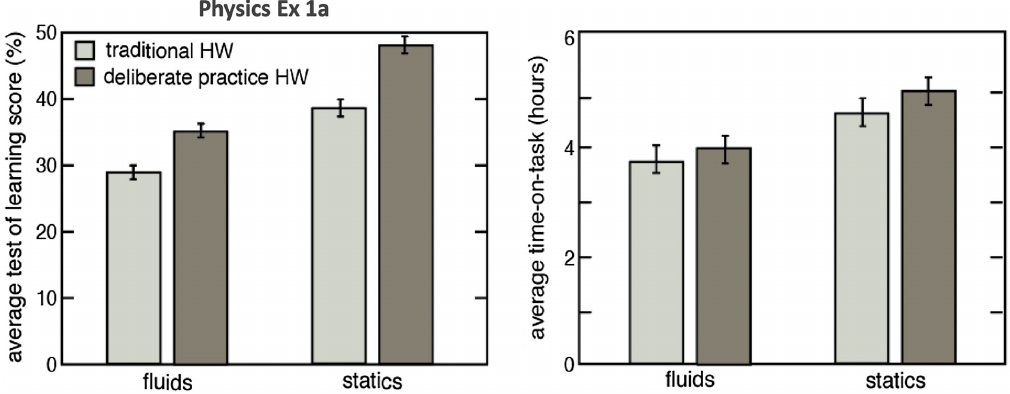
FIG. 4. (a) Average performance on the tests of learning and (b) average time on task for students who completed the traditional homework (light gray) compared to those who completed the deliberate practice-based homework (dark gray). The same protocol was repeated for two physics topics (statics and fluids). Error bars on both plots show 1 SE.